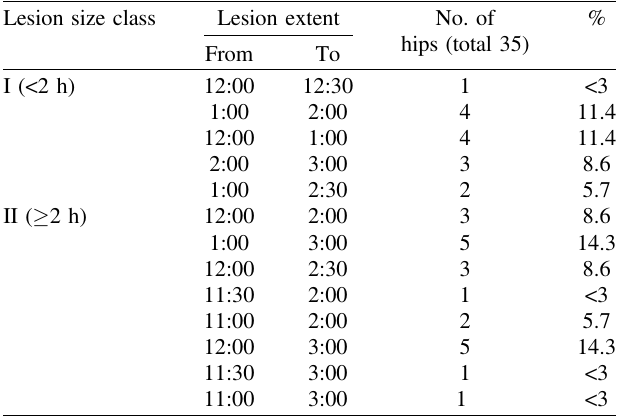
Figure 5. Signi fi cant differences found when patients with Cam and torn labrum were compared with those with mixed FAI and torn labrum.